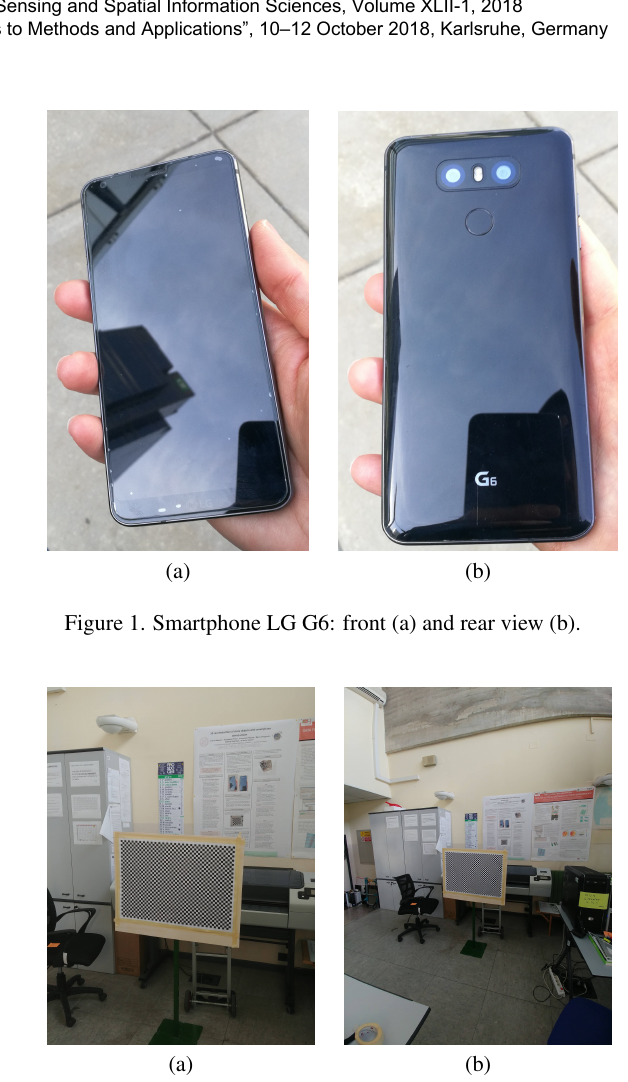
Figure 2. Sample image acquired by main LG G6 camera (a) and wide-angle one (b).